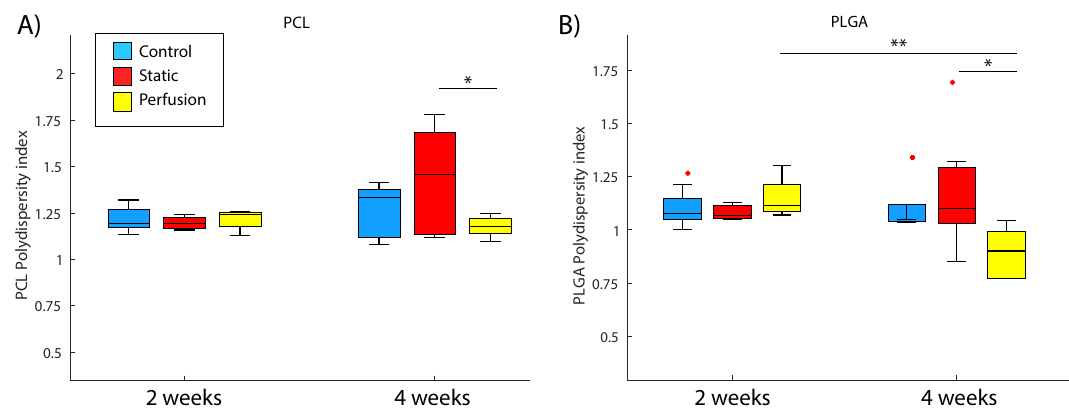
Figure 6. Gel permeation chromatography results: ( A ) PCL and ( B ) PLGA -polydispersity index of samples after 2 and 4 weeks of incubation for the different conditions: control (blue), static (red) and perfusion (yellow). PIs were quantified as Mw/Mn ratios of different samples. Measurements from control samples were done at the same time points but samples did not undergo any incubation.